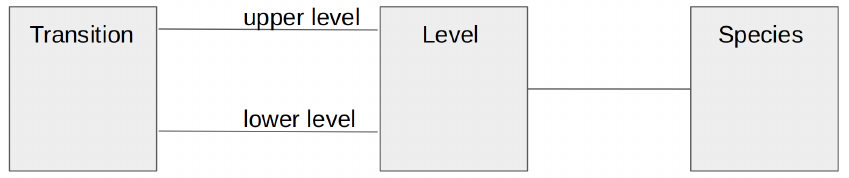
Figure 1. Core structure of the databases